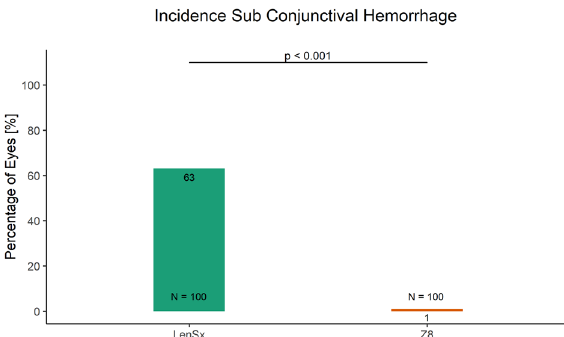
Figure 3. The proportion of eyes with incidence of subconjunctival hemorrhage in the LenSx and the Z8 laser group.